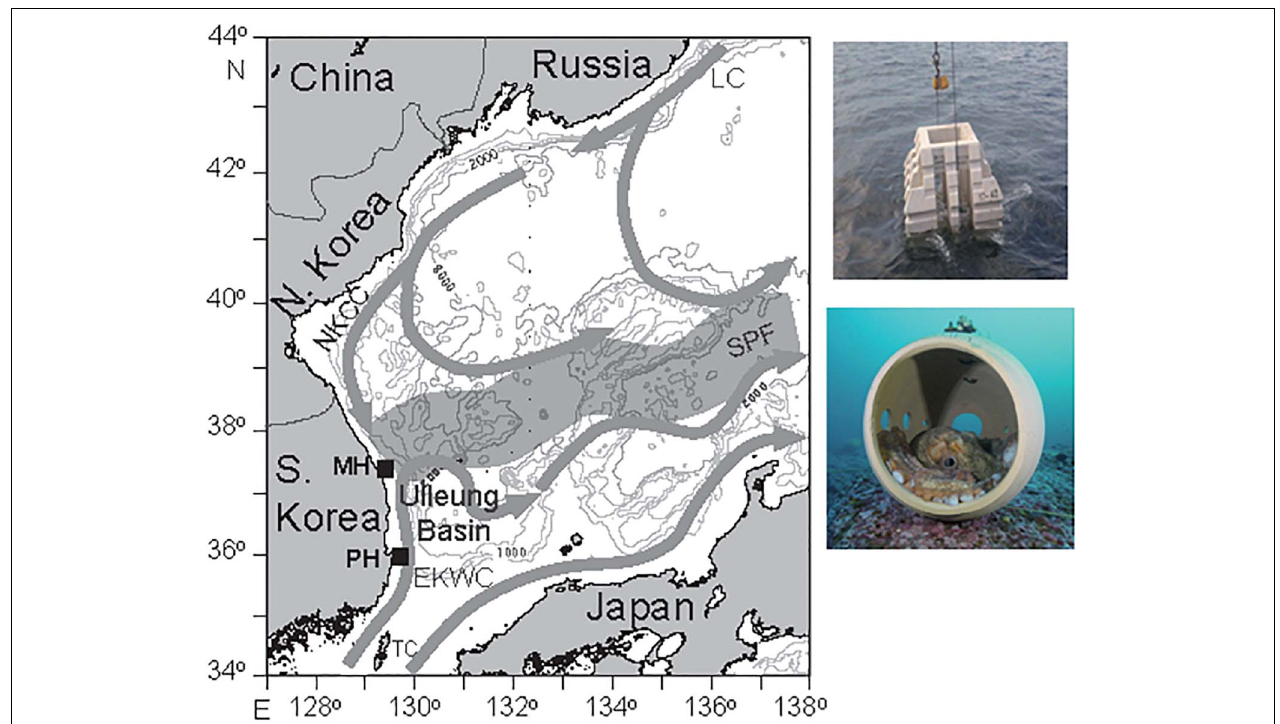
FIGURE 1 | Map showing the study location off the east coast of the Korean peninsula and the sampling sites of the Mokho coast (MH) and the Pohang coast (PH). Photos of artificial reefs (truncated square concrete pyramids with holes and round pots) deployed are included. LC, Liman Current; NKCC, North Korean Cold Current; EKWC, East Korea Warm Current; SPF, Subpolar Front; and TC, Tsushima Warm